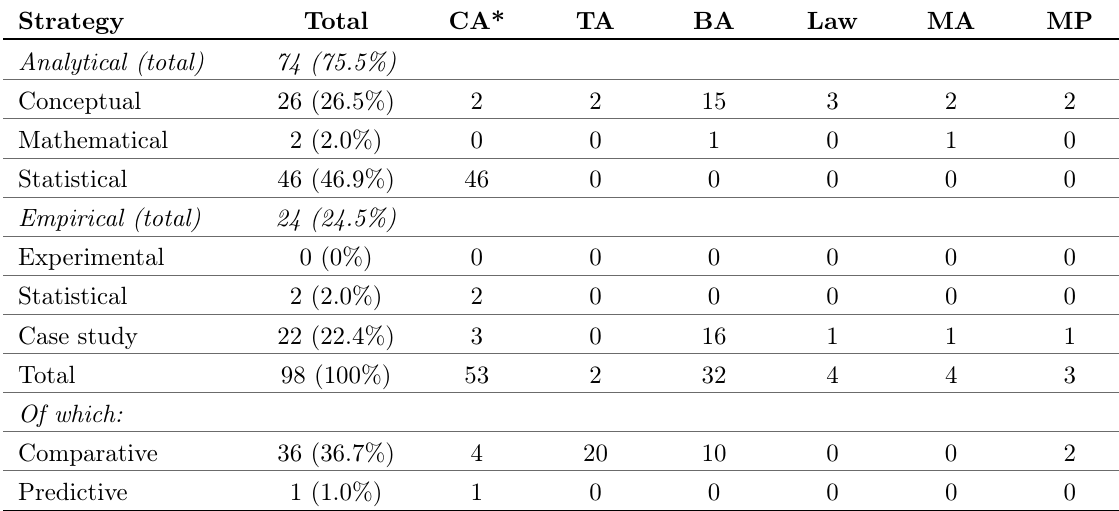
Table 8. Research strategy in mobile payments